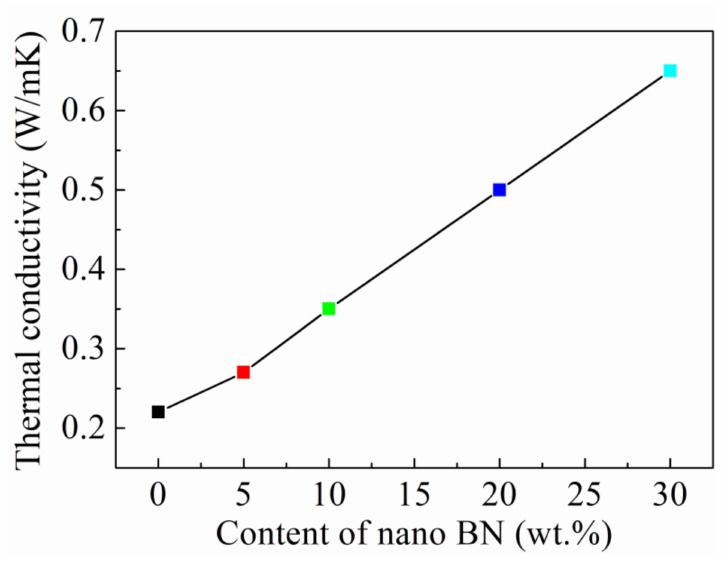
Figure 3. Thermal conductivity of Ep/PHO30 thermally conductive adhesive system.